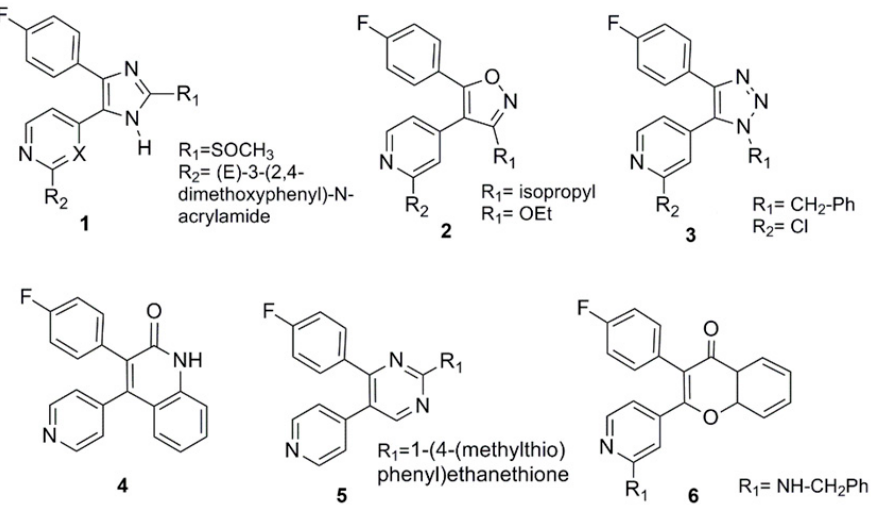
Figure 2. Stilbene-based p38 inhibitors characterized by a vicinal 4-fluorophenyl/4-pyridine motif.